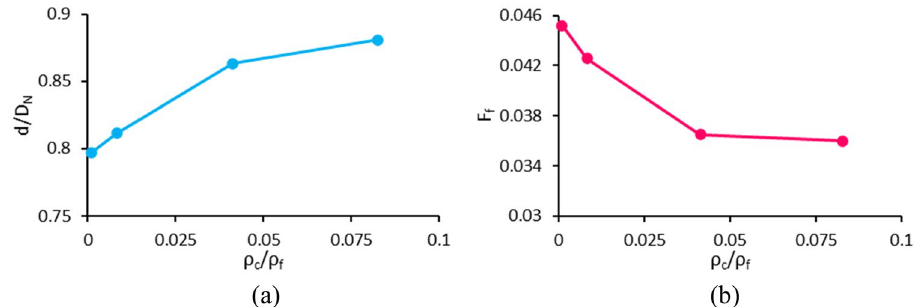
Figure 21. Variation of ( a ) the dimensionless droplet diameter and ( b ) formation frequency versus the continuous phase to ferrofluid density